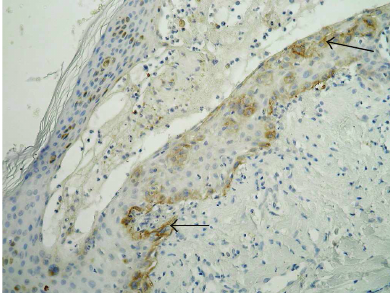
Figure 2: Healthy skin, immunohistochemistry. Signal for β 1 inte- grin in single keratinocyte (original magnification x400).